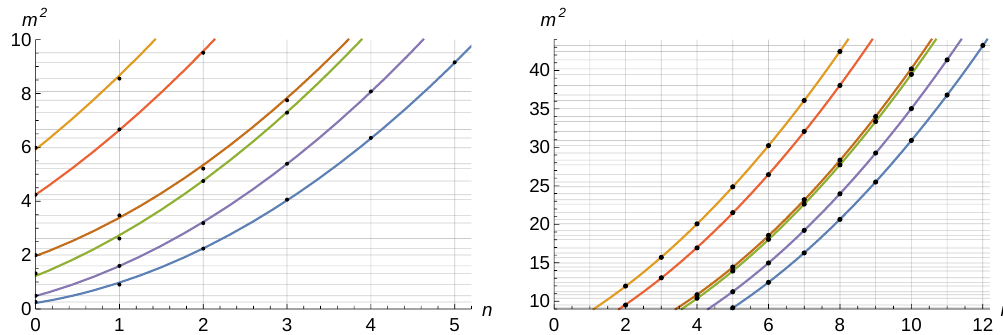
Figure 2 . Quadratic fits of the 0 − + spectrum of m 2 found in [72]. The black dots (as well as the grids) indicate the masses and the curves are fits (4)–(9). n is the “radial” quantum number labeling excited states. The left panel shows the behavior of the fits for m 2 ≤ 10 . The intercepts correspond to the ground states. The right panel illustrates the quality of the fits for m 2 ≥ 10 . All mass values are shown in the units of the ground state mass of 2 ++